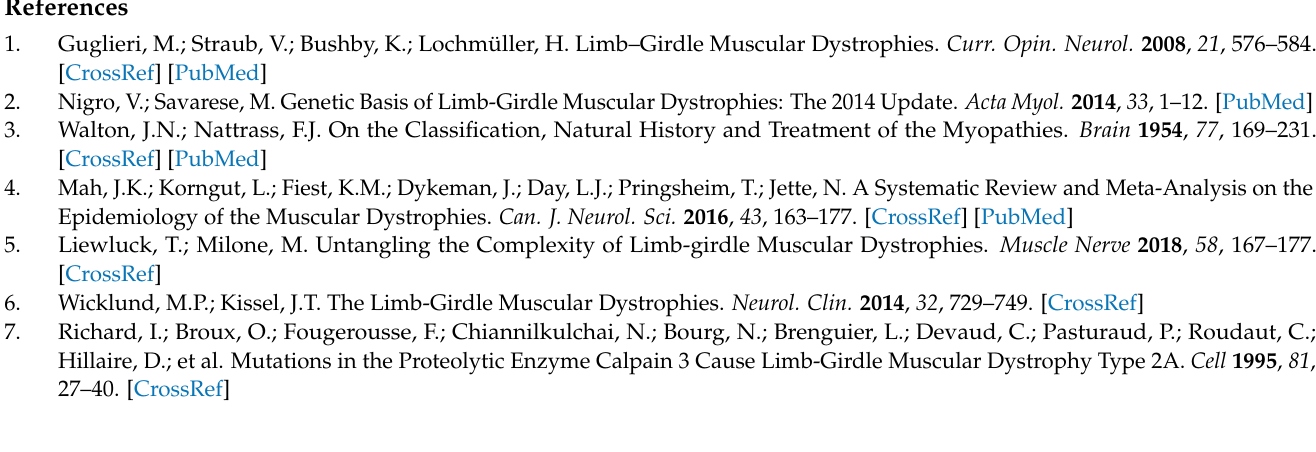
Figure S2. Molecular characterization of TNN- and TTN-eGFP hiPSC and skMC Figure S3. Char- acterization of control and LGMDR9-affected hiPSC Figure S4. Characterization of FKRP -affected hiPSC differentiation into SkMC. Movie S1. Troponin I-eGFP skMt maturation. Movie S2. Titin-eGFP skMt maturation Table S1. Classification and nomenclature of LGMD. Table S2. Primers used for the measurement of the 27 genes causing LGMD by qPCR Table S3. Antibodies used for immunostaining of the 27 proteins causing